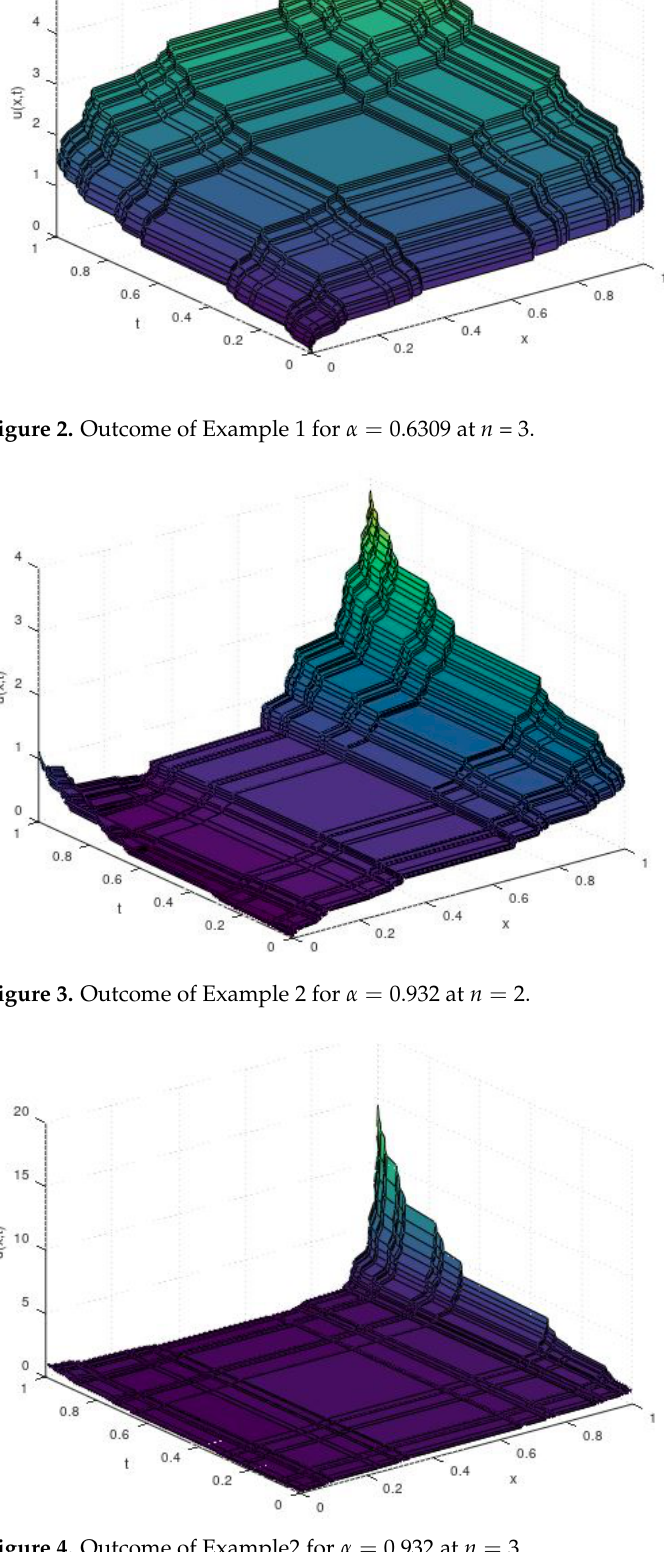
Figure 4. Outcome of Example2 for α = 0.932 at n =